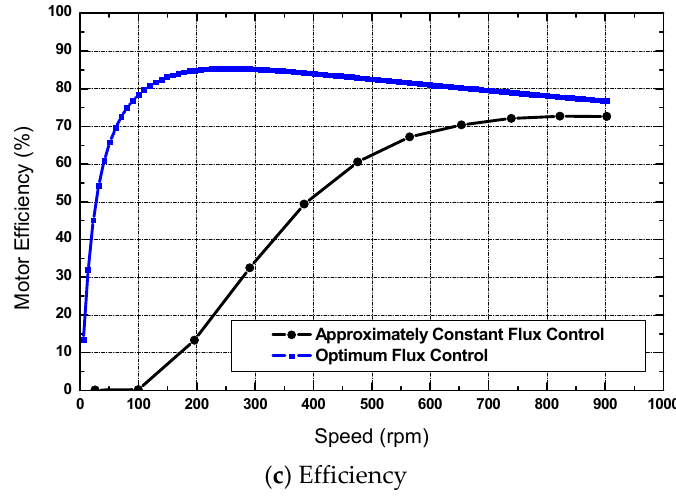
Figure 7. Motor characteristics at constant and optimum flux operation versus speed.